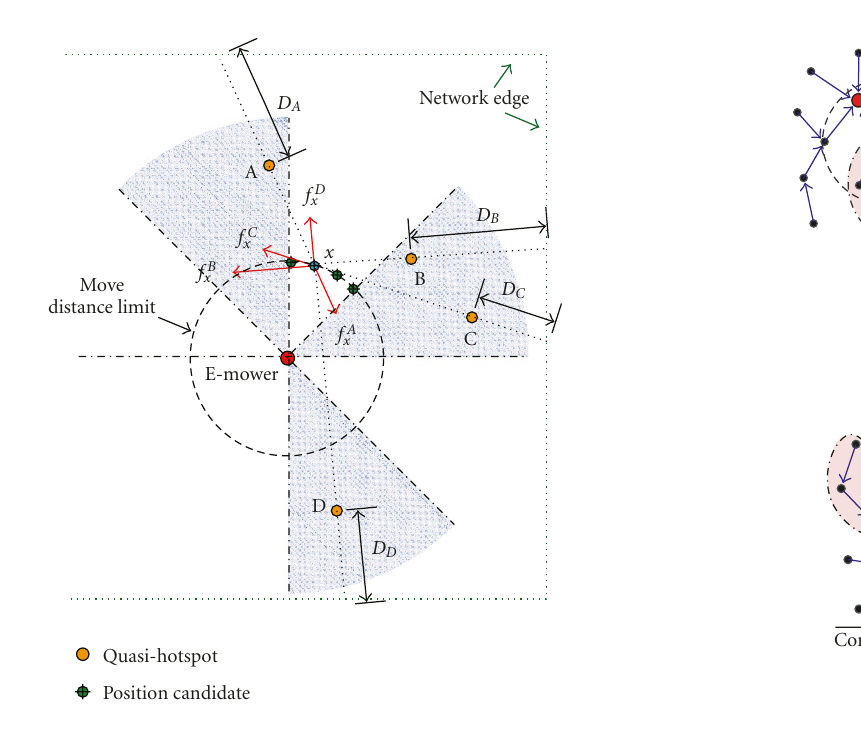
Figure 2: Influence forces acting on a position candidate x from all the four quasi-hotspots (nodes A, B, C, and D) in the network.